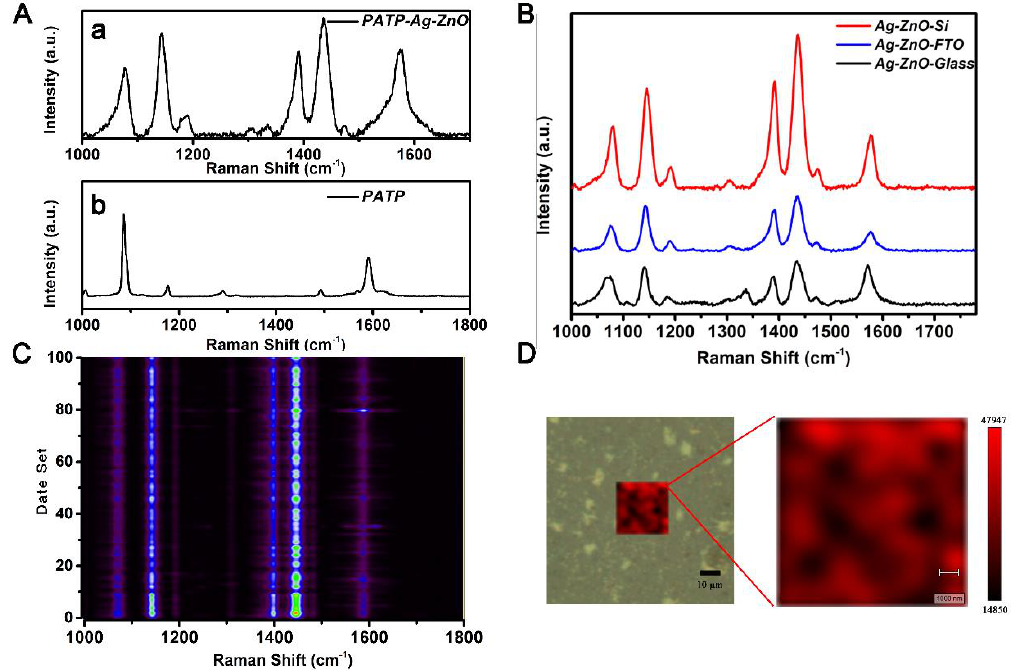
Figure 5. ( A ) a—SERS spectra of 10 − 5 M PATP on the Ag–ZnO–Si substrate, b—SERS spectra of PATP powder; ( B ) SERS spectra of 10 − 5 M PATP on Ag–ZnO substrate supported by different substrates; ( C ) Raman mapping images of 10 − 5 M PATP adsorbed on the Ag–ZnO nanorod array substrate; ( D ) Raman intensity distribution map at 1434 cm − 1 in the selected range. Table 1. The measured frequencies of the Raman bands and their assignments for PATP and DMAB. PATP DMAB